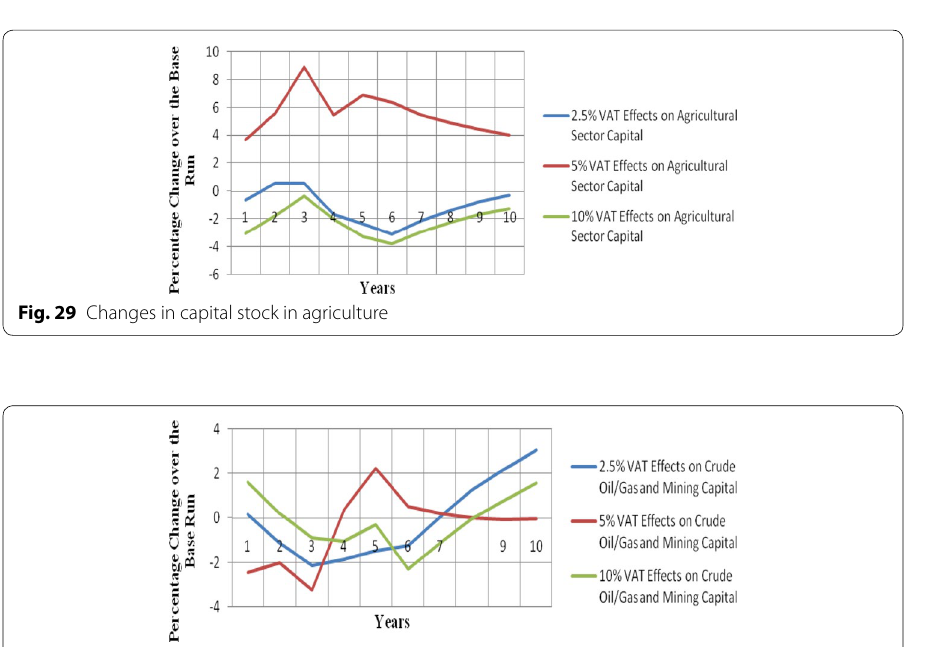
Fig. 30 Changes in capital stock in crude oil/gas and